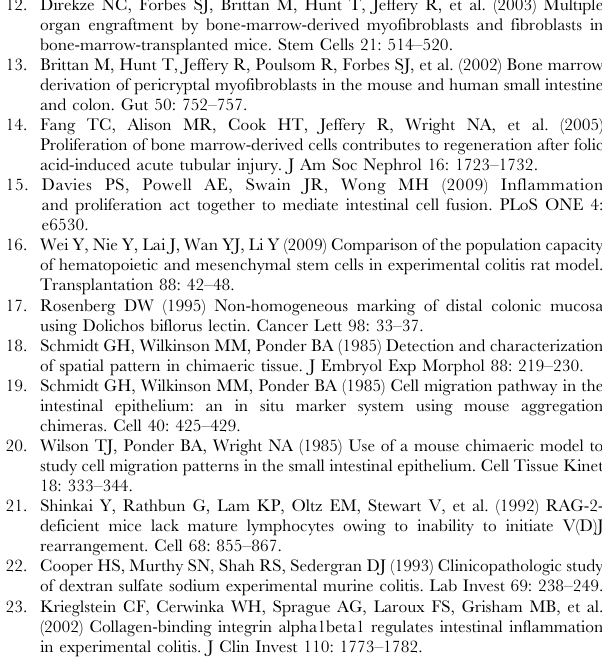
Protocol S1 Details of the triple immunohistochemistry and subsequent chromosomal in situ hybridisation methods may be found in the Protocol S1